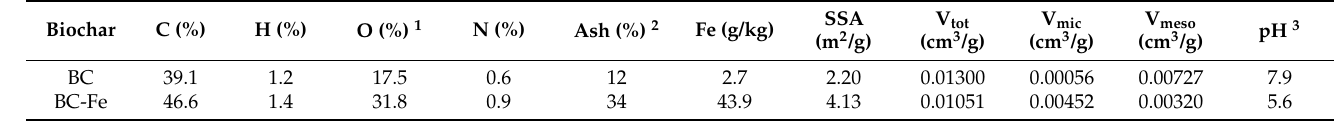
Table 1. Selected properties of BC and BC-Fe.